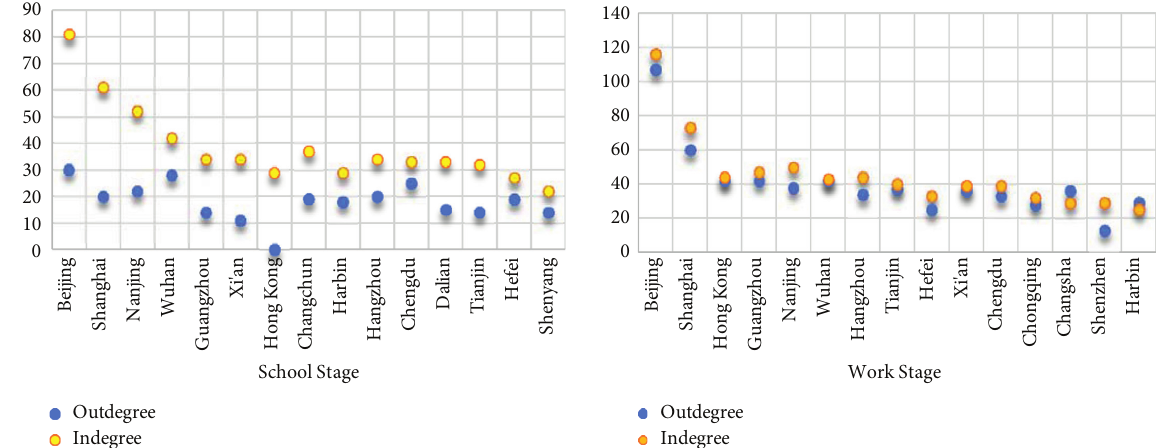
Figure 5: Node degree centrality at different stages. Note: only the top 15 nodes with degree centrality are